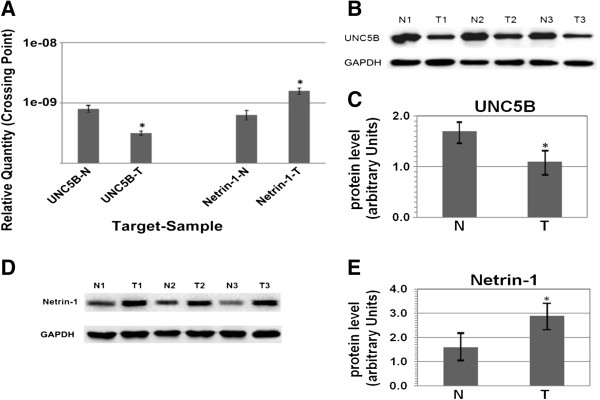
Expression by RT-PCR and western blot in BC tissues (T) and normal bladder tissues (N). (A) The average netrin-1 & UNC5B expression ± SD for all studied tumors (120 cases) and their corresponding normal tissues (40 cases) by RT-PCR, bar graphs describe significant UNC5B down-regulation and netrin-1 up-regulation in T in comparison with N (P < 0.05), β-actin as an internal control. (B) UNC5B protein was detected by western blot in 40 pair tissues and band intensities indicate UNC5B expression conspicuously lower in T comparing with N. GAPDH was used as a loading control. (C) The ratio between the optical densities of UNC5B & GAPDH in the same tissue was calculated and expressed graphically. Significant differences of UNC5B expression between T & N were analyzed statistically and UNC5B expression was obviously greater in N (P < 0.05). (D) Netrin-1 protein was detected by western blot and increased in T. (E) The relative protein expression of netrin-1, GAPDH as an internal control (P < 0.05).